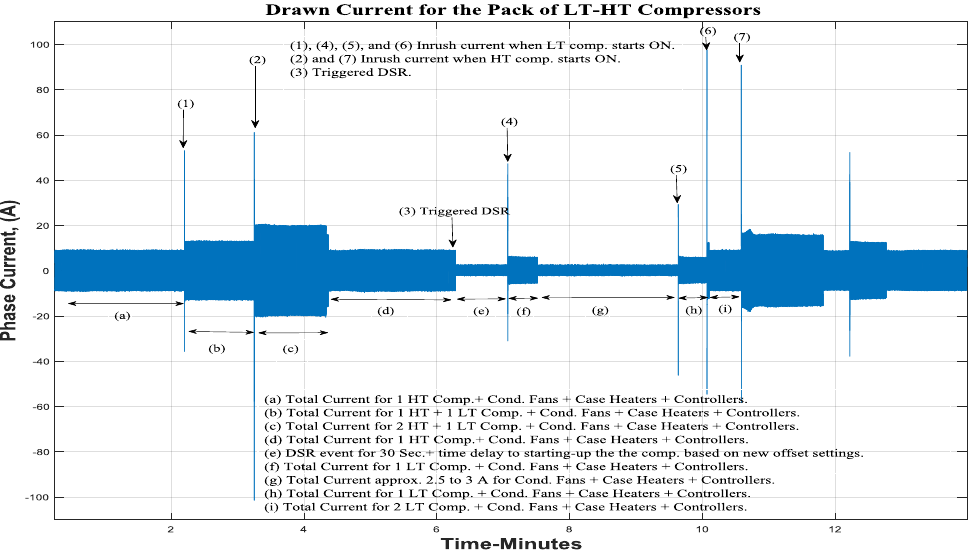
Figure 11. One phase drawn current for the 3Ø refrigeration pack system before and after DSR for the first 15 min of continuous operation.